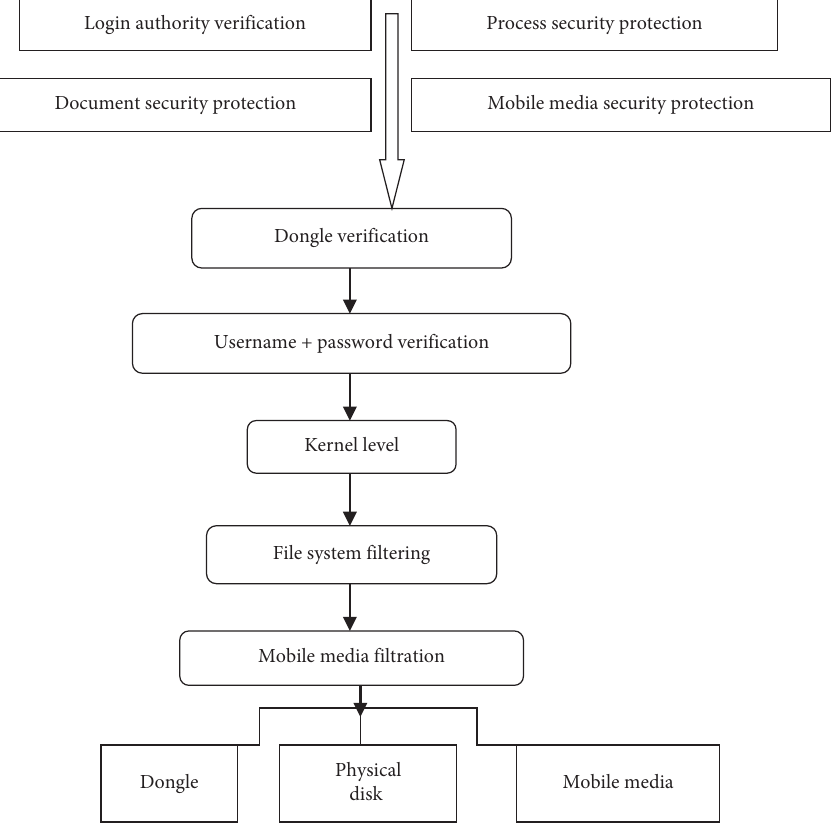
Figure 1: Architecture diagram of the computer multimedia security protection